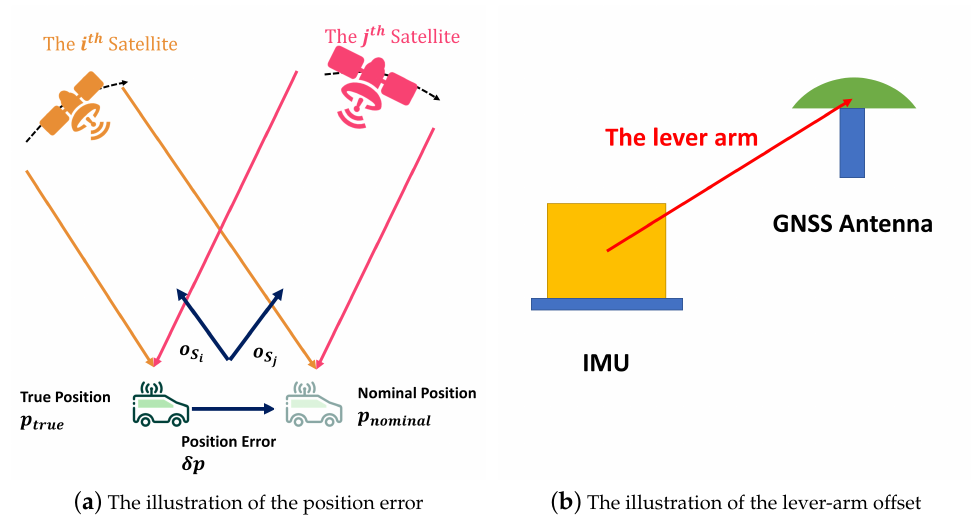
Figure A1. The position error and the lever-arm